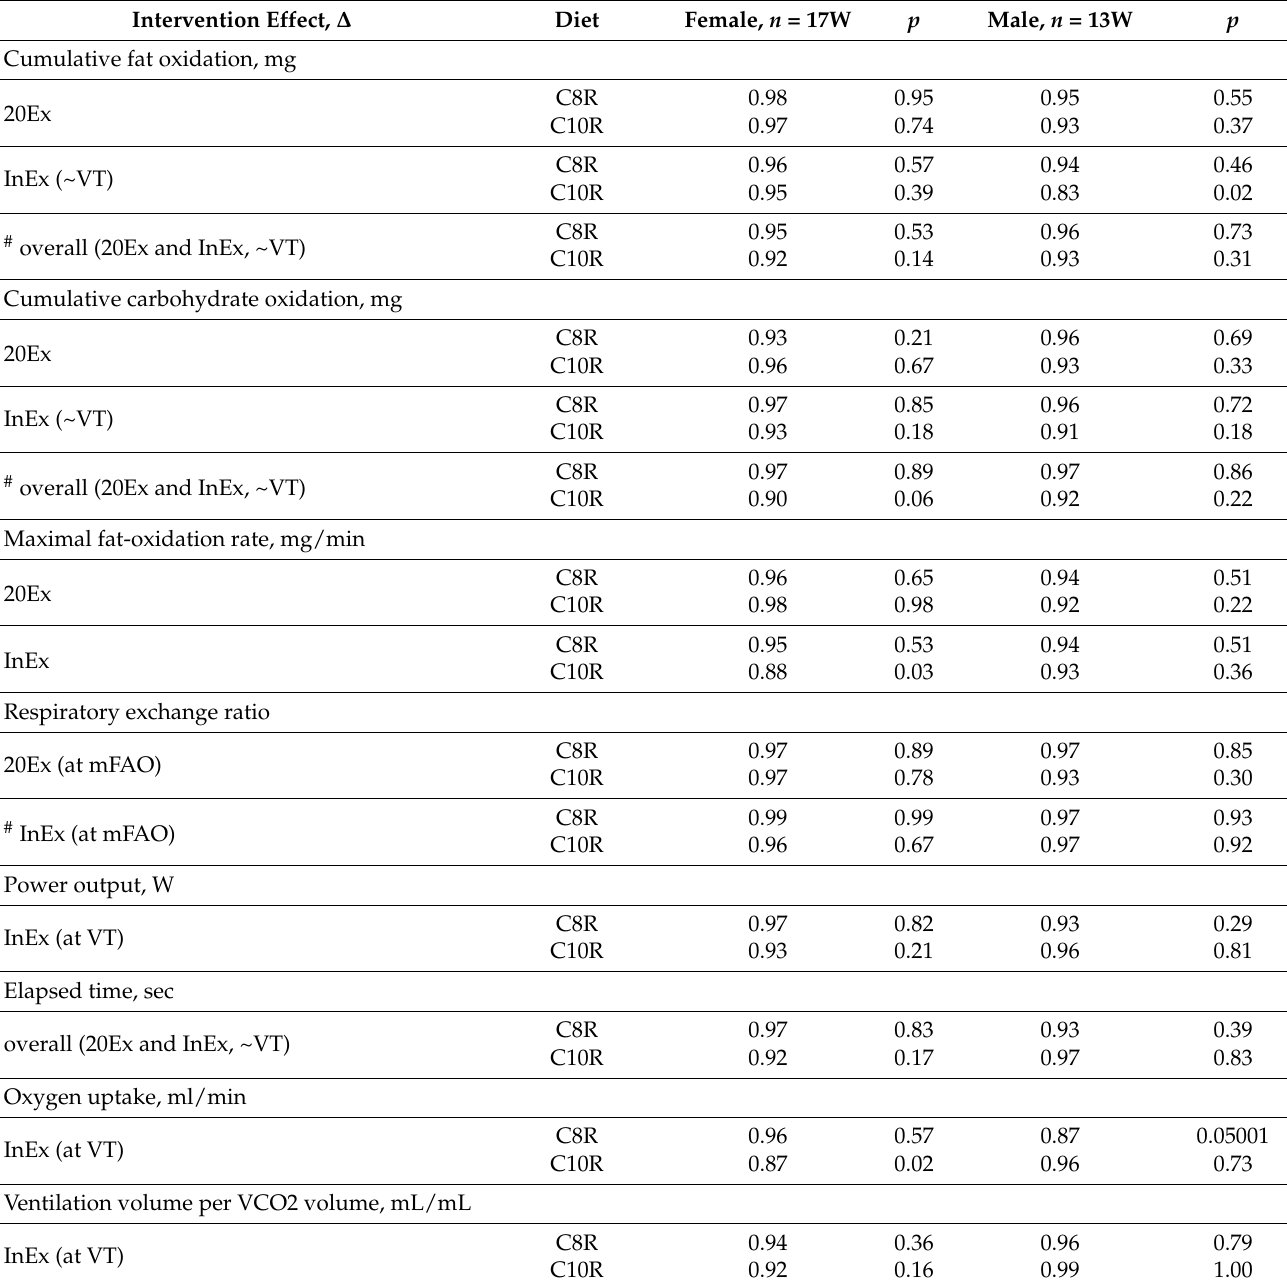
Table A1. Statistical analyses of normality distribution on the data of intervention